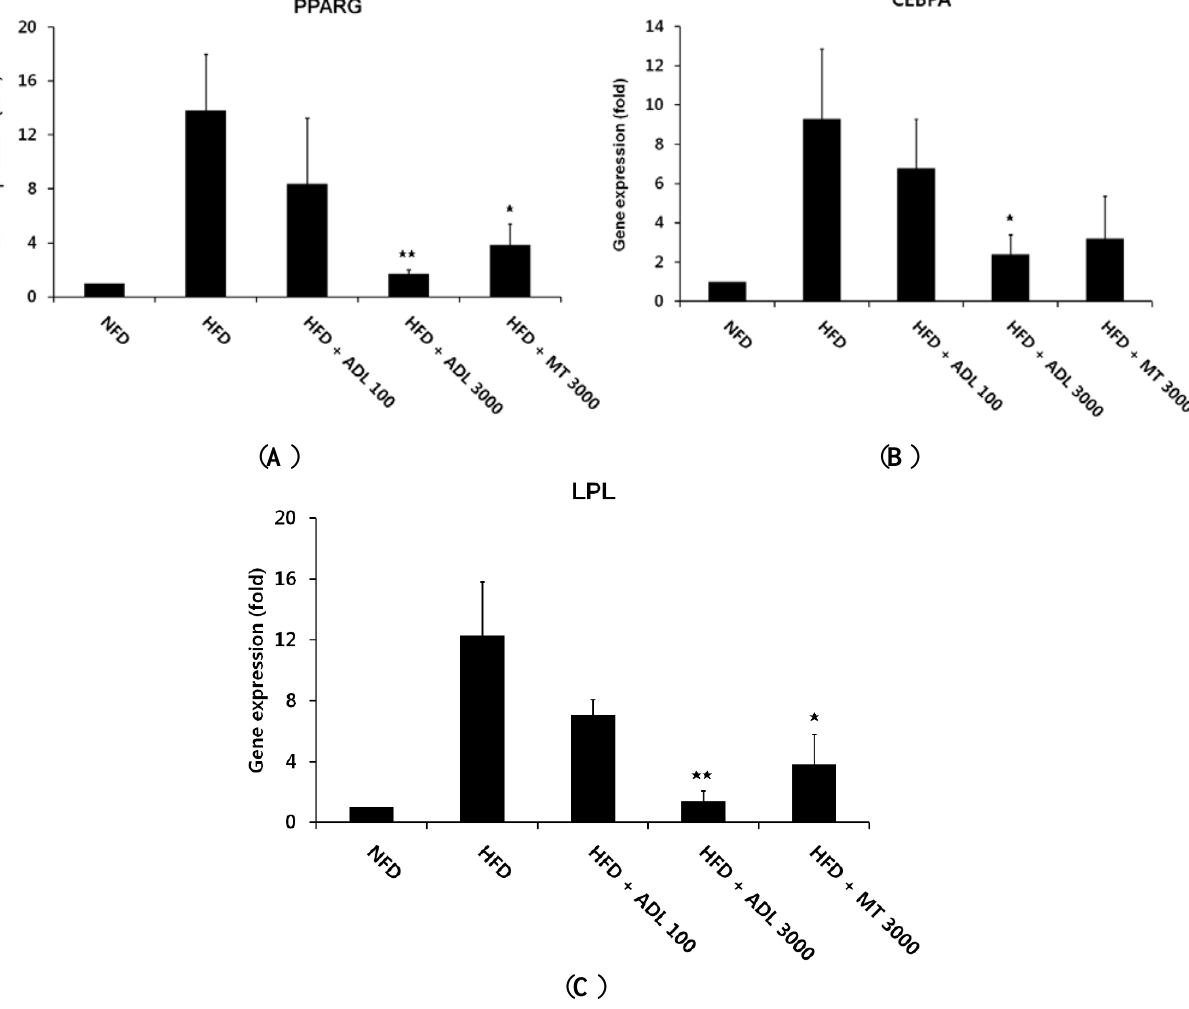
Figure 2. Changes in PPARG ( A ); CEBPA ( B ); and LPL ( C ) gene expression in epididymal adipose tissues of mice fed experimental diets for six weeks was analyzed by real-time PCR. Normal-fat diet (NFD), high-fat diet (HFD), high-fat diet with 100 mg·kg −1 ·day −1 Allomirina dichotoma larva suspension (HFD + ADL 100), and HFD with 3000 mg·kg −1 ·day −1 ADL (HFD + ADL 3000). Bars represent mean ± SD ( n = 3). Statistical significance was evaluated by Duncan post-hoc test in ANOVA.  p < 0.01 and  p < 0.05, compared to the high-fat diet